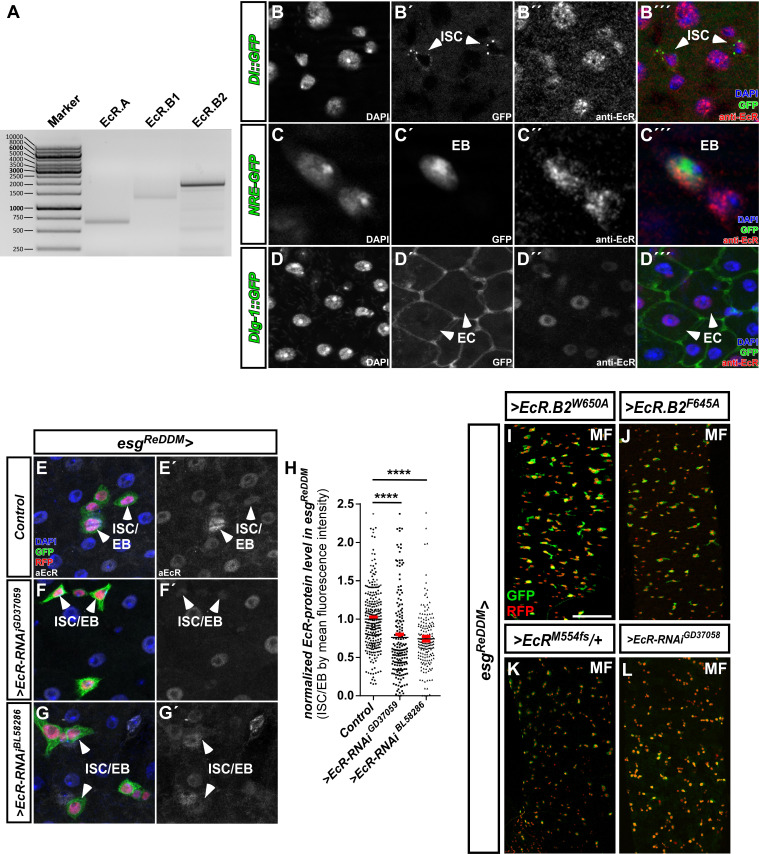
The EcR is expressed in the adult Drosophila midgut.(A) Expression analysis of Ecdysone-receptor splice variants with specific primer sets performed on cDNA transcribed from mRNA isolations of whole midgut dissections of adult MF. (B–D) Antibody staining against all EcR variants in PMG of adult MF using transgenic lines for the ISC-specific Notch-ligand Delta tagged with GFP (Dl::GFP, B-B’’’ inset magnification) and Notch responsive element marking EB (NRE-GFP, C-C’’’ inset magnification). Absorptive differentiated EC were identified using the GFP-tagged septate junction marker Dlg-1 (D–D’’’). Shown are single fluorescence channels including DAPI and merge (B’’’–D’’’). (E–H) Representative images of esgReDDM driving EcR-RNAis showing reduction of EcR immunoreactivity (F–G’). (H) in situ quantification of EcR levels by fluorescence intensity measurements in esgReDDM after seven days of tracing. Confocal images were taken at identical excitation and emission settings. Single GFP+/RFP+ progenitor cell nuclei were measured using Fiji and statistically analyzed (n = 272,179,179) using one-way ANOVA with Bonferroni's Multiple Comparison Test (*p<0.05, **p<0.01; ***p<0,001; ****p<0.0001). (I–L) Forced expression of dominant-negative EcR.B2-variants (I+J), heterozygosity with the EcRM554fs-allele (K) and a second EcR-RNAi (L) after seven days of esgReDDM-tracing in adult PMG of MF. Scale bars = 100 µm.Figure 1—figure supplement 1—source data 1.Data from Figure 1—figure supplement 1.Panel H experimental data.